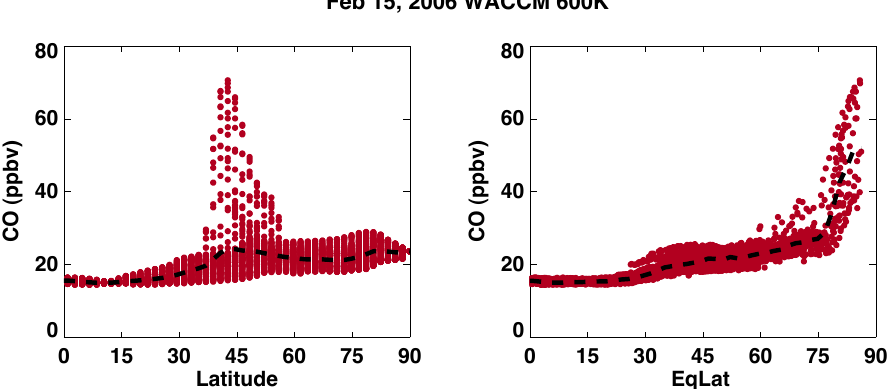
Fig. 4. Scatterplots of WACCM CO at 600K as functions of latitude (left) and equivalent latitude (right). The black dashed lines represent the zonal means (calculated in 1.9 ◦ intervals) in latitude or EqLat coordinates,